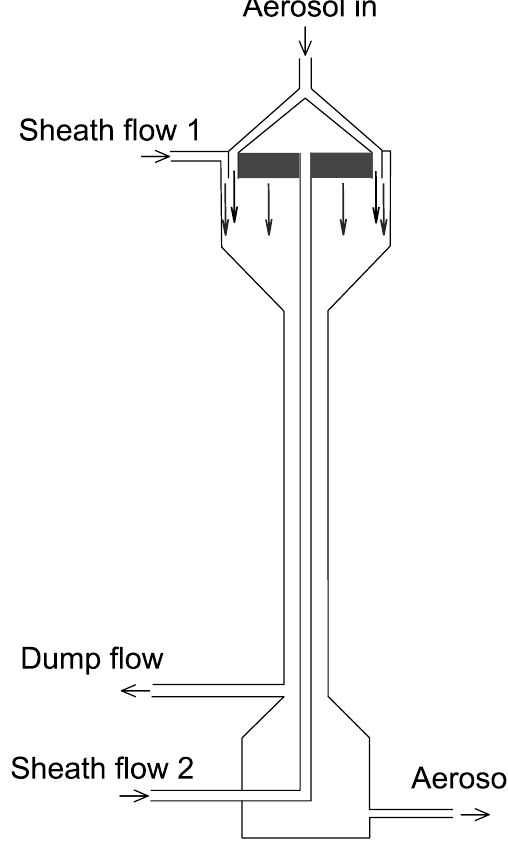
Fig. 1. A scheme of the dielectrophoretic classifier